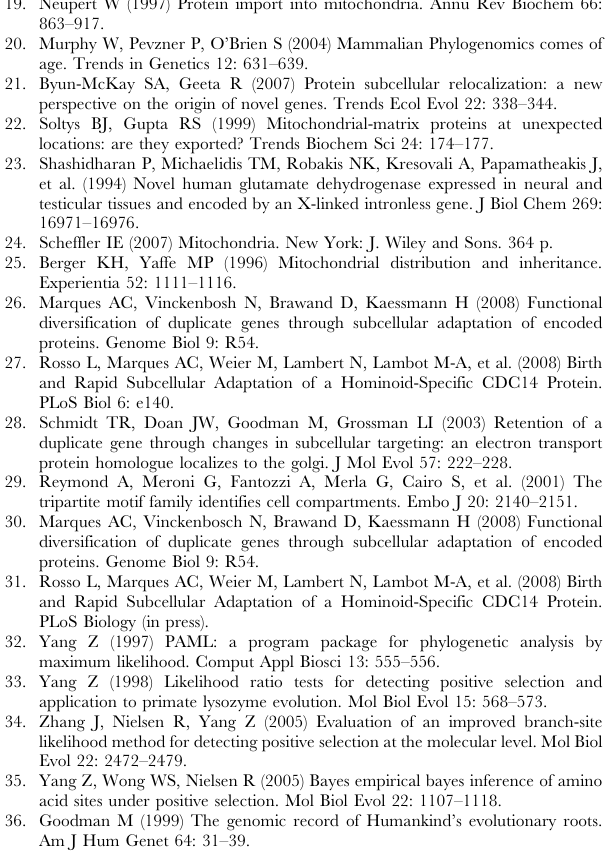
Figure S1 Subcellular Localization of GLUD MTS-GFP Fusion Proteins. See legend of Figure 1 and main text for details. Figure S2 Proportion of Cells With Localization of GLUD1/ GLUD2 MTS-GFP Proteins Restricted to Mitochondria. (A) COS7 cells. (B) HeLa cells.